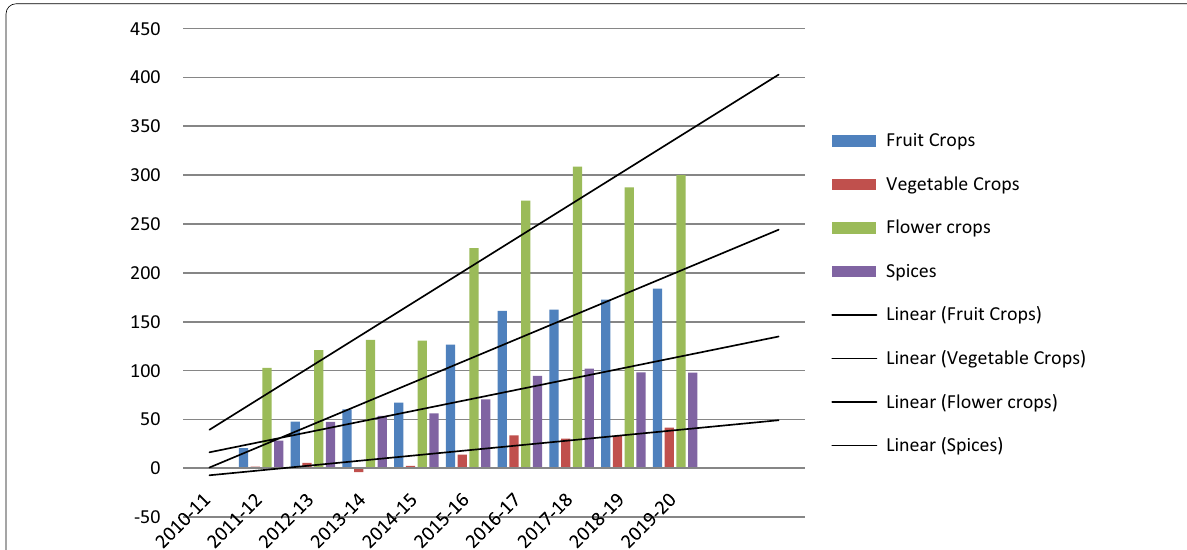
Fig. 14 Per cent growth rate of fruit, vegetable, flower and spice crop area during 2010–2020 suggests a general increased growth trend in area and its linear forecast also indicates a positive growth trend in Madhya Pradesh